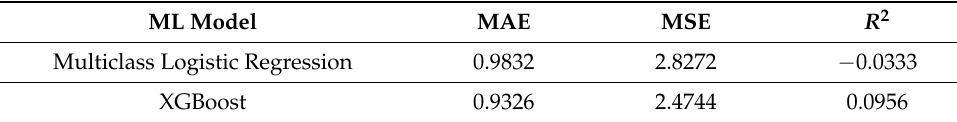
Table 12. Logistic regression and XGBoost MAE, MSE and R 2